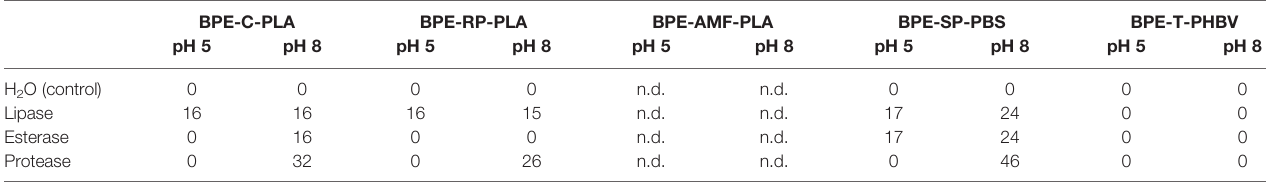
TABLE 3 | Diameter (mm) of clear zones formed around the area of enzyme application for lipase, esterase, and protease on plates of the BPE-polymers at pH 5 and pH 8.